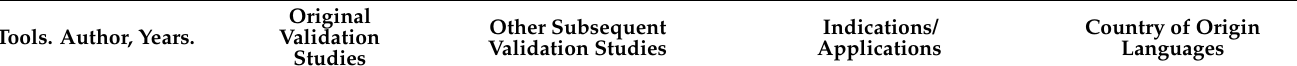
Table 2. Characteristics of the included assessment